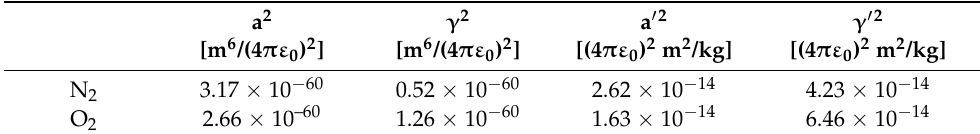
Table A3. Molecular constants.